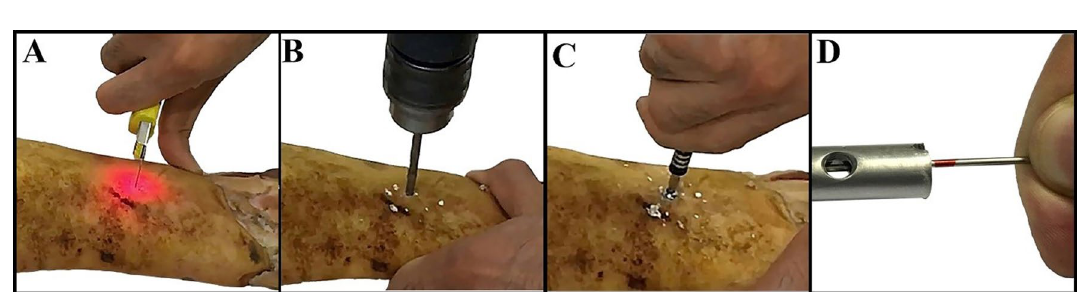
Figure 3. ( A ) IMN holes laser indicator and ( B ) a schematic image of positioning IMN hole using the IMN holes laser indicator.